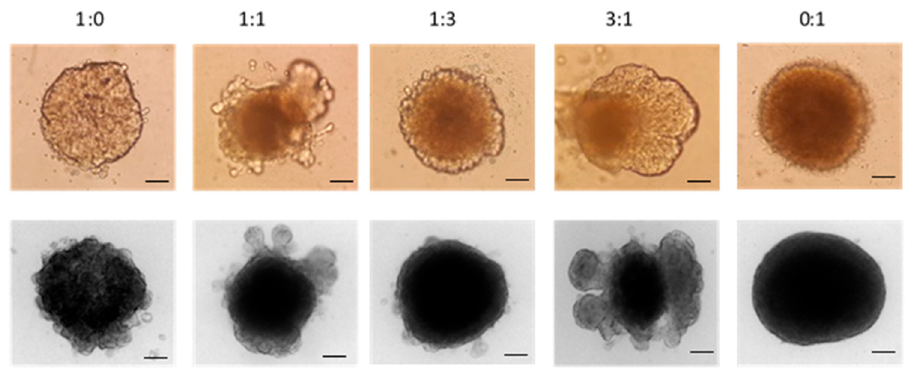
Figure 11. 3-Dimensional (3D) spheroids including different ratio MCF-7: HDF cell mixture. The light microscope images (top row) and brightfield microscope images (bottom row). Original magnification: 10× . Scale bar is 50 µ m.